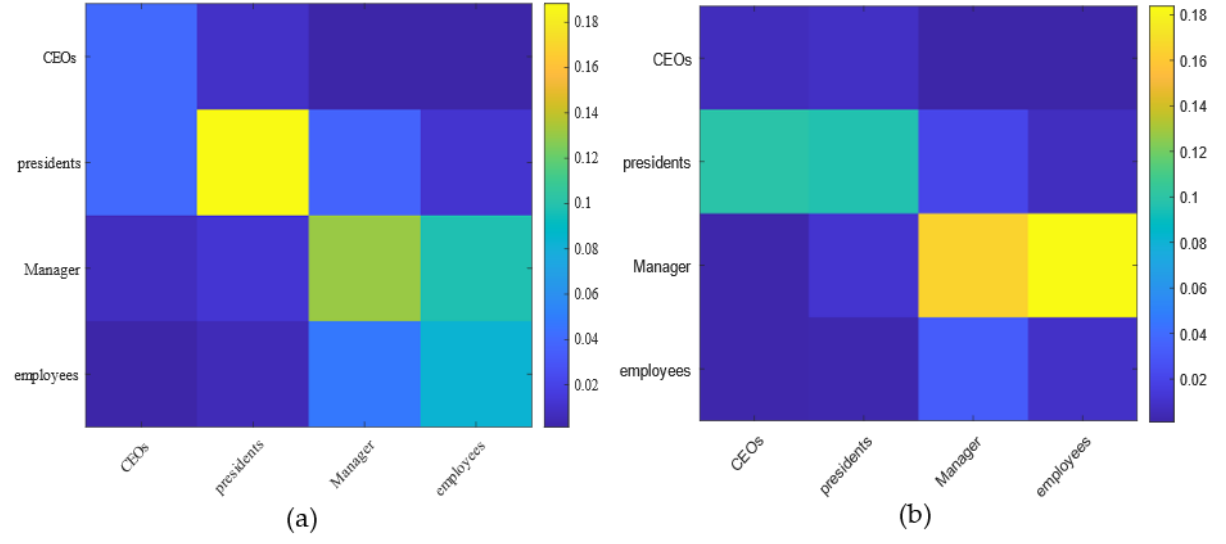
Figure 8. The comparison of community probability in normal week and event week. ( a ) indicates the normal week(week 59), ( b ) indicates the event week (the 89 weeks when CEO Jeffrey resigns).